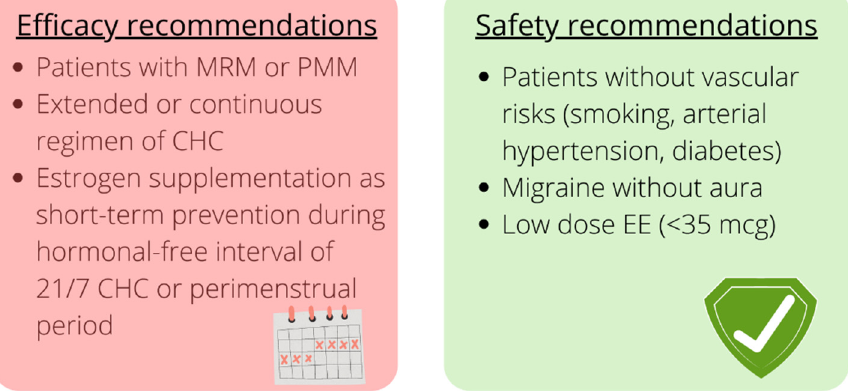
Figure 2. Summary of the main efficacy and safety recommendations for the use of hormonal treat- ments in menstrual migraine (MM) prevention. Created with BioRender.com (2022). Abbreviations: CHC: combined hormonal contraception, EE: ethinylestradiol, MRM: menstrually related migraine, PMM: pure menstrual migraine.